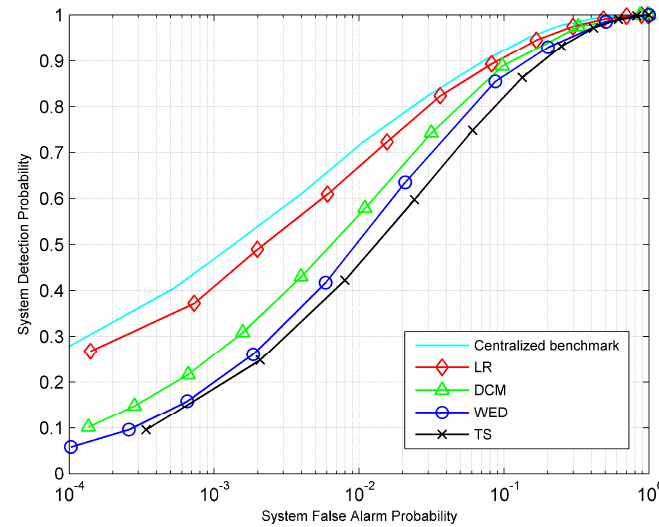
Figure 2. Receiver operating characteristic (ROC) curves for different fusion rules at S = 0